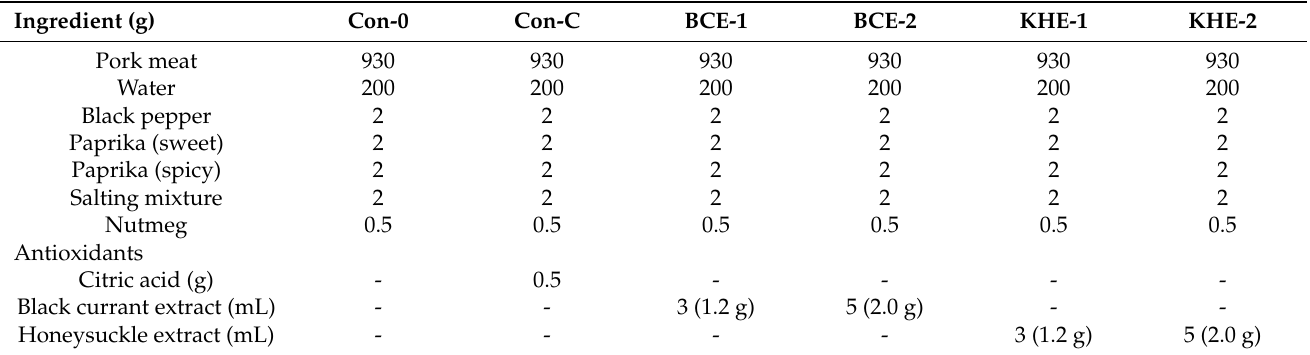
Table 1. Ingredients used to prepare 1kg of final